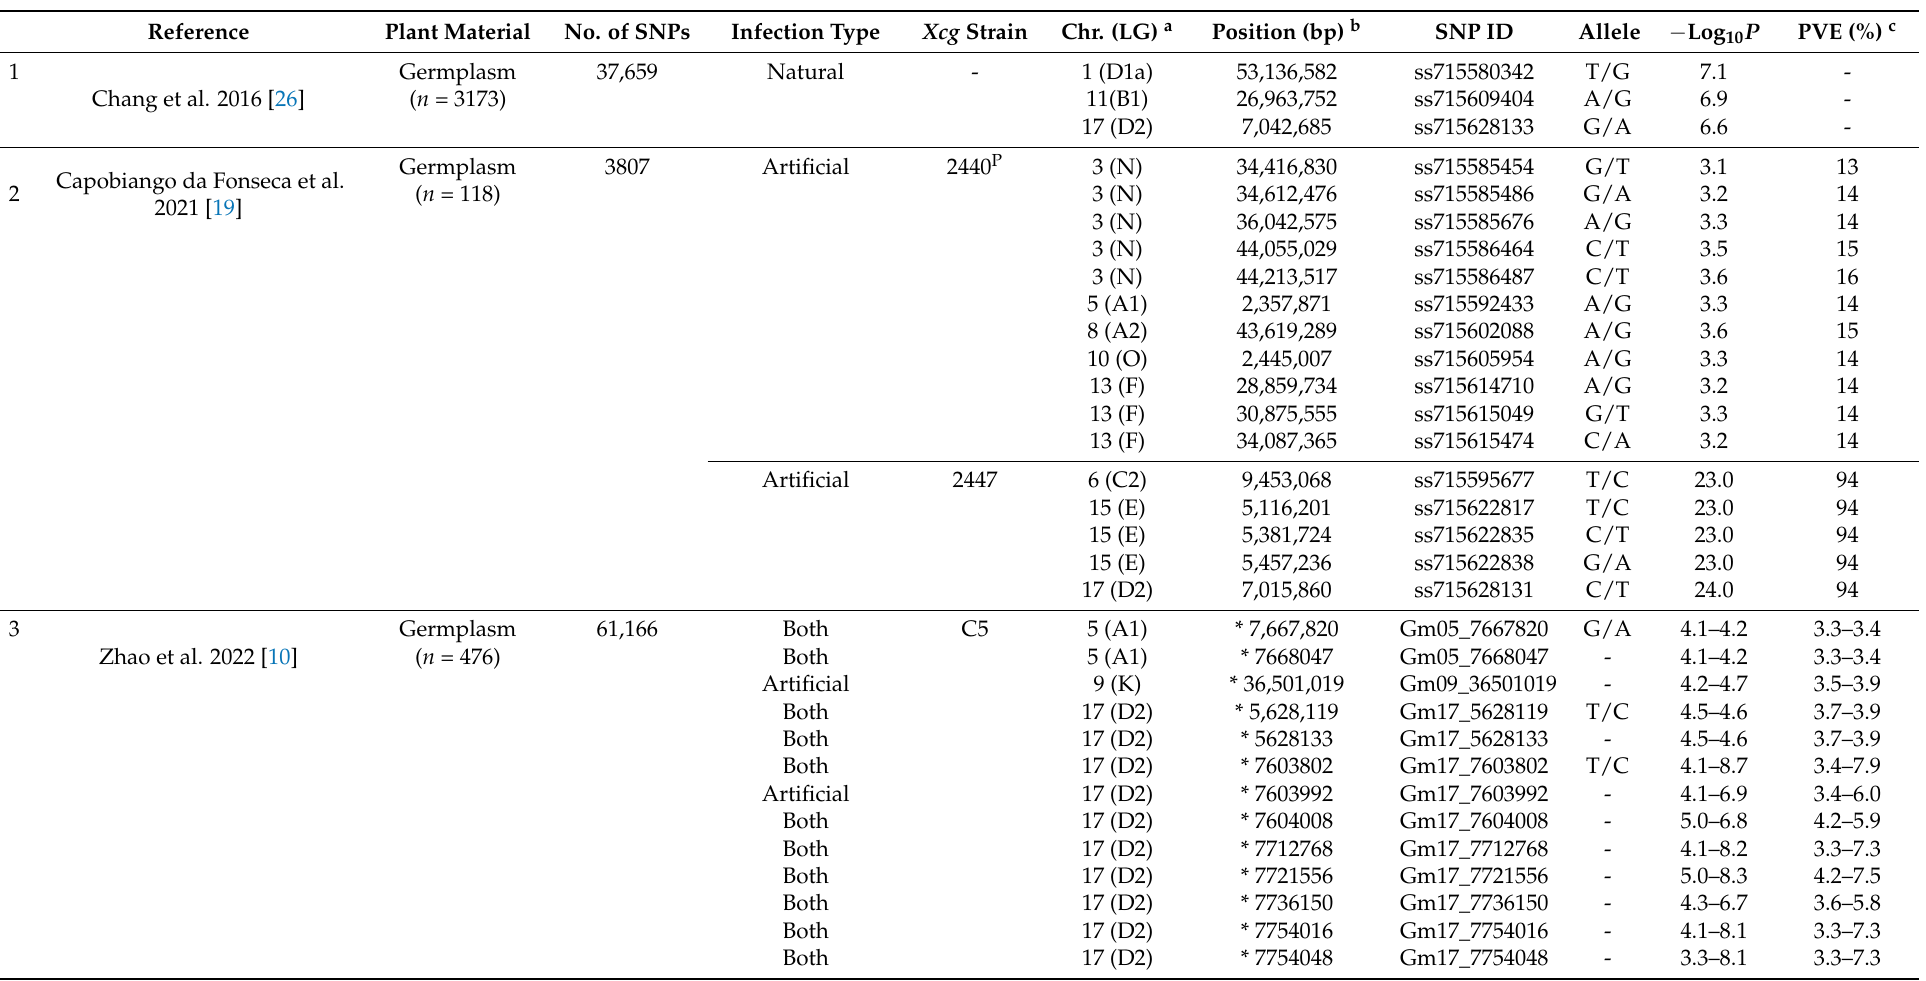
Table 2. Single nucleotide polymorphisms (SNPs) associated with resistance to bacterial pustule in the previous genome-wide association study